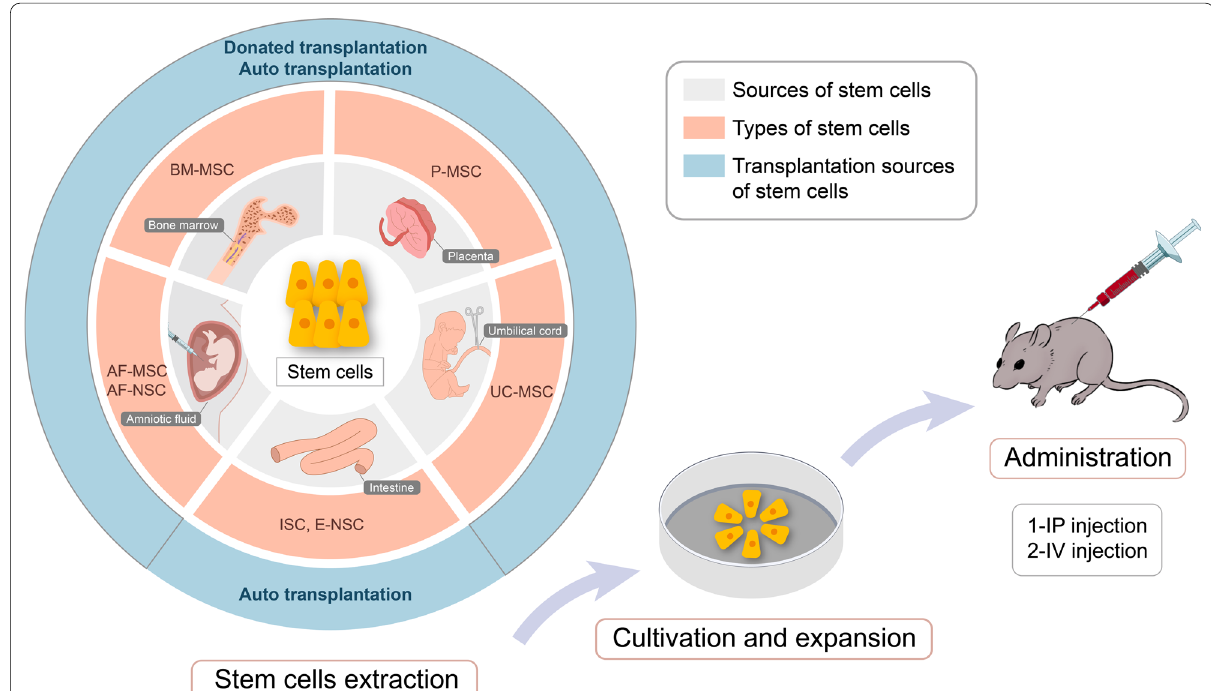
Fig. 3 Stem cells from various sources are transplanted into NEC models. First, stem cells are isolated and extracted from various tissues including the intestine, bone marrow, amniotic fluid, umbilical cord, and placenta. Among, ISC and E‑NSC are autologous, BM‑MSC, AF‑MSC, UC‑MSC, P‑MSC, and AF‑NSC can be administered into NEC animal models by the donor or autologous transplantation. Then, extracted stem cells are propagated in an incubator. Finally, these cultured stem cells will be transported into NEC animal models via IP or IV injection. BM-MSC bone marrow‑derived mesenchymal stem cell; UC-MSC umbilical cord‑derived stem cell; AF-MSC amniotic fluid‑derived mesenchymal stem cell; AF-NSC neural stem cell isolated from the amniotic fluid; E-NSC enteric neural stem cell; ISC Intestinal stem cell; P-MSC placental‑derived mesenchymal stem cell;